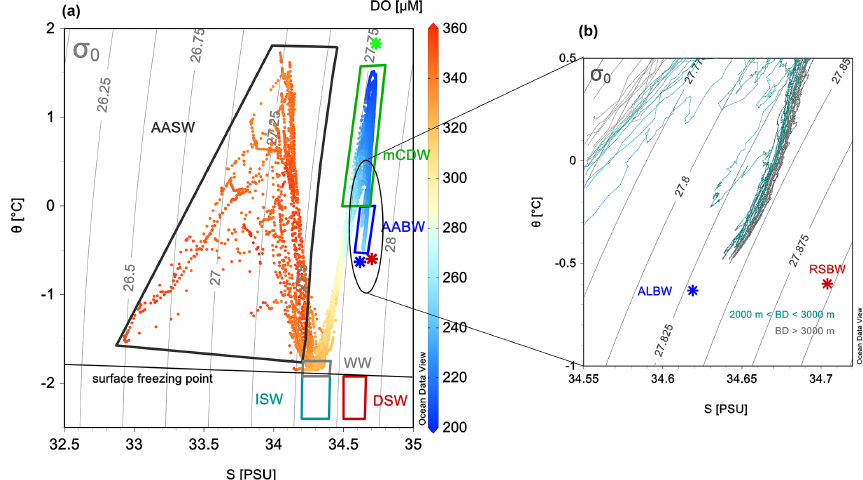
Figure 3. θ – S diagram (a) with colours referring to dissolved oxygen concentration (colourbar on the right). Characterization of the prin- cipal water masses according to Silvano et al. (2017, 2020): AASW – Antarctic Surface Water, WW – Winter Water, mCDW – modified Circumpolar Deep Water, AABW – Antarctic Bottom Water (with properties captured at 150 ◦ E), ISW – Ice Shelf Water and DSW – Dense Shelf Water. Zoom of the θ – S diagram (b) into the deepest layers where bottom depths (BDs) are larger than 2000m. Endmembers of RSBW – Ross Sea Bottom Water (red asterisk), ALBW – Adélie Land Bottom Water (blue), and CDW (green) are indicated according to Thomas et al.